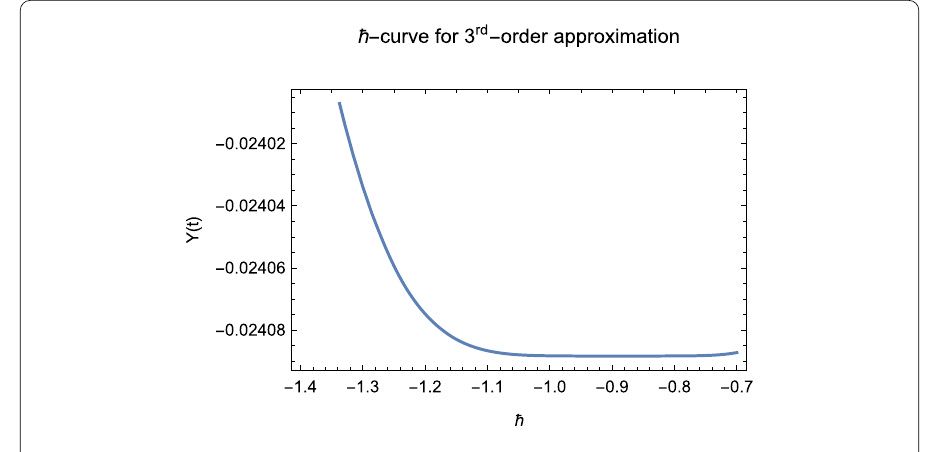
Figure 3 The h -curves of the third-order approximations for Y ( t )